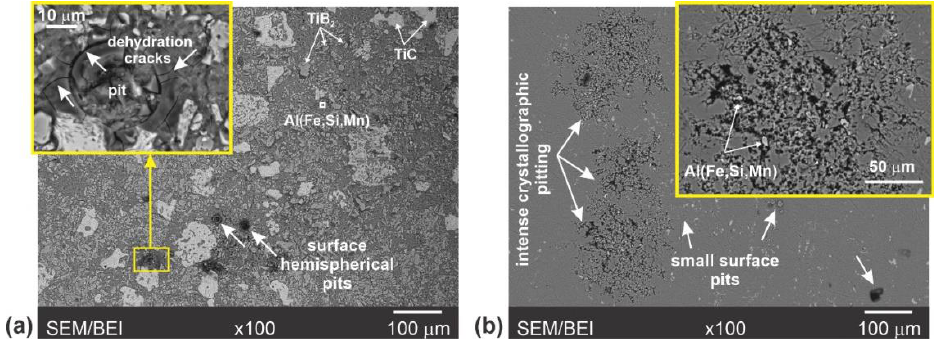
Figure 11. SEM / BEI surface observation after CP measurements in 0.5 M NaCl solution; ( a ) LSA TiC / TiB 2 / Al composite coating processed with LED of 13.3 J / mm 2 and ( b ) untreated / substrate Al alloy sample.